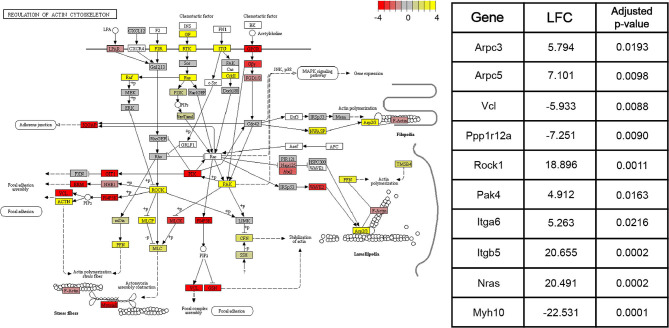
Pathway graph displaying the “Regulation of actin cytoskeleton” pathway from the KEGG (Kanehisa and Goto, 2000) database (mmu04810). This pathway was significantly activated (adjusted p < 0.01) between the 4 and 15 week age groups. Between the 15 week and 8 month age groups, the pathway is non-significantly inhibited (adjusted p = 0.09), while between the 8 month and 22 month age groups, the pathway is significantly activated (adjusted p < 0.05). Colors of each node correspond to the sum of DESeq2's shrunken log2 fold changes (LFCs) for genes associated with that node. Shrunken LFCs are indicated by the color scale in the top right corner. Overall, the log2 fold changes of 126 constituent genes are annotated on the pathway graph. White nodes correspond to transcripts for which read count data was not available. Some nodes represent multiple proteins with similar or redundant functions.